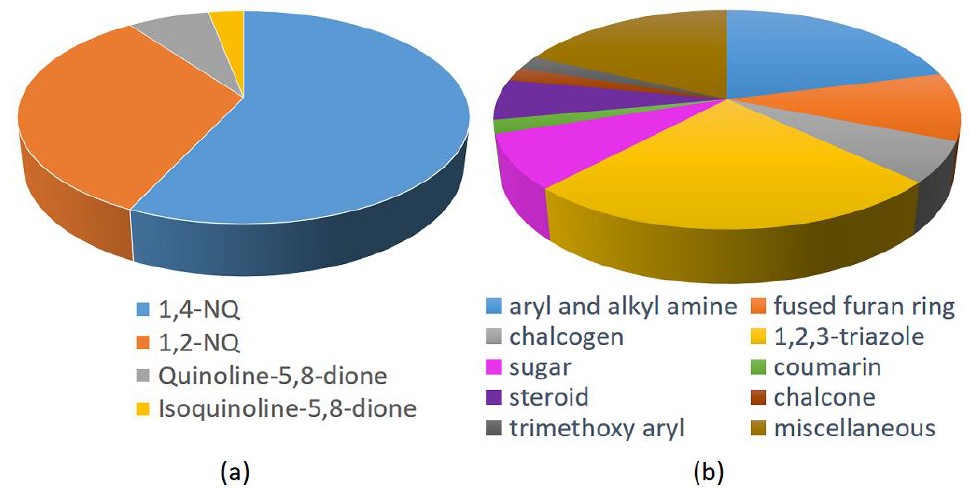
Figure 36. Relative abundance of scaffolds used in the molecular hybridization: ( a ) naphthoquinone types, and ( b ) other fragments, as reported in the papers herein reviewed.